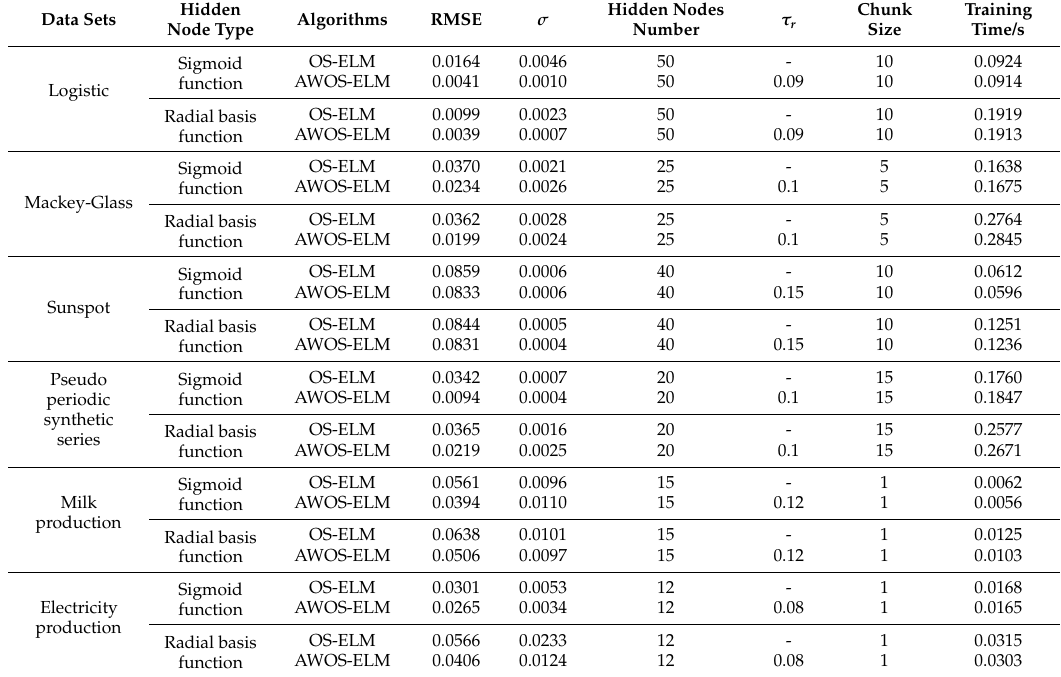
Table 1. Performance comparison between AWOS-ELM and OS-ELM on benchmark data sets. RMSE, rooted mean squared errors.